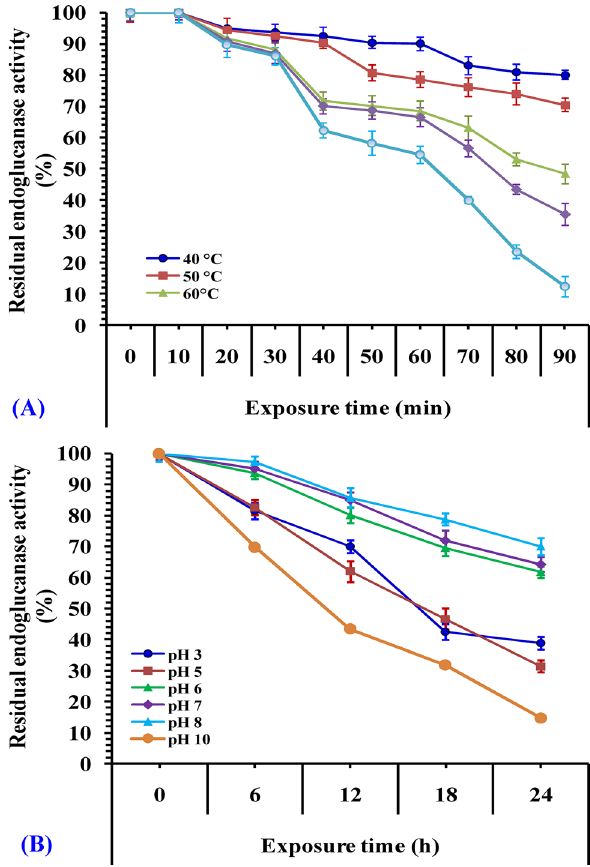
Figure 10. Thermal and pH stability of endoglucanase enzyme ( A ) pH stability of endoglucanase enzyme at different times of the reaction ( B ) Thermal stability of endoglucanase as a function of the time of the reaction.